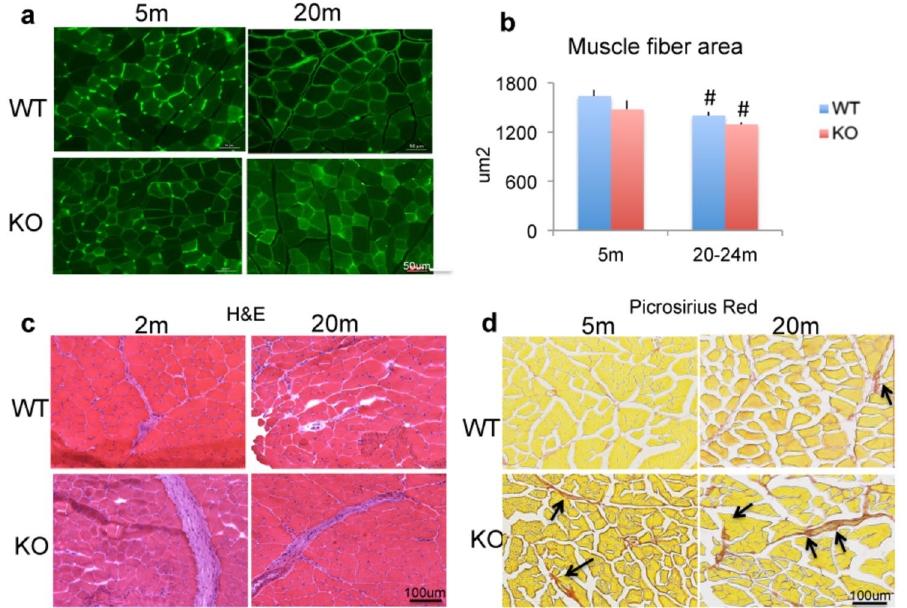
Figure 4. Histomorphometric analysis of muscle from WT and Fgf2KO mice. Muscle sections from tibialis anterior muscle in 5-month and 20–24 months old WT and Fgf2KO mice. ( a ) Laminin-stained sections reveal overall reduced myofiber cross sectional area is observed within old WT and old Fgf2KO mice. ( b ) Quantitative analysis of cross-sectional area of skeletal muscle from 3 mice/group revealed significant reduction in old WT and old Fgf2KO compared with respective young genotype. # Compared to corresponding 5 m p < 0.05. ( c ) Muscle sections from tibialis anterior muscle in young and old (2 months and 22 months) WT and Fgf2KO stained with hematoxylin and eosin reveal large swaths of ECM/collagen deposition and increased inflammatory infiltrate in young and old Fgf2KO as well as old WT. ( d ) Picroriues red staining for collagen showed increased fibrosis (arrows) in the muscle of 20 m-WT and 5 m Fgf2KO compared with 5 m WT, and further increased in 20 m